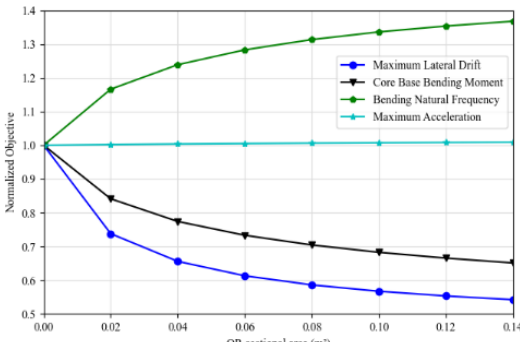
Figure 4. Influence of the OR area regarding the objectives/criteria